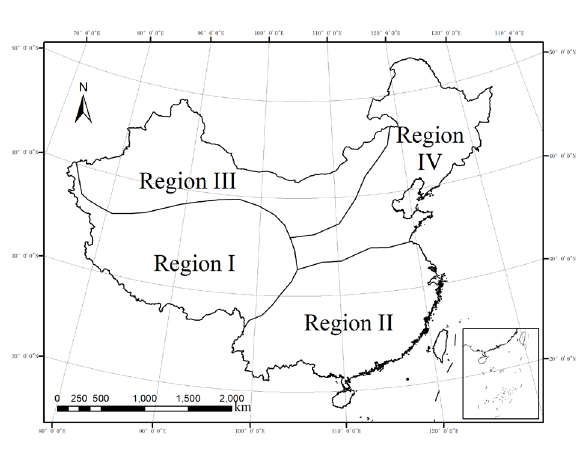
Figure 2. The main climate zones in China Region I has a polar climate, mainly the tundra (ET)